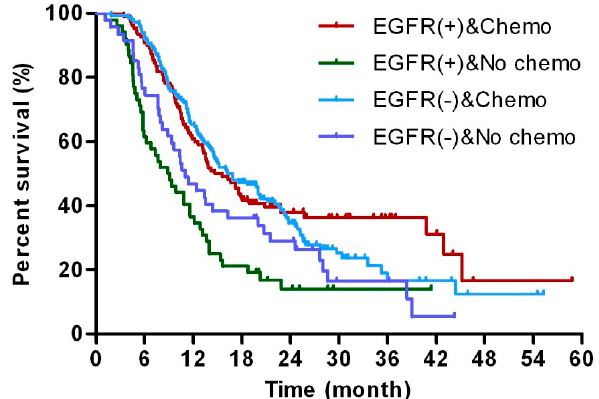
Figure 3. Subgroup analysis of adjuvant chemotherapy. Kaplan–Meier estimates of survival of patients who received adjuvant chemotherapy (Chemo) or refused chemotherapy (No chemo) according to EGFR status: EGFR (+) or EGFR ( − ).